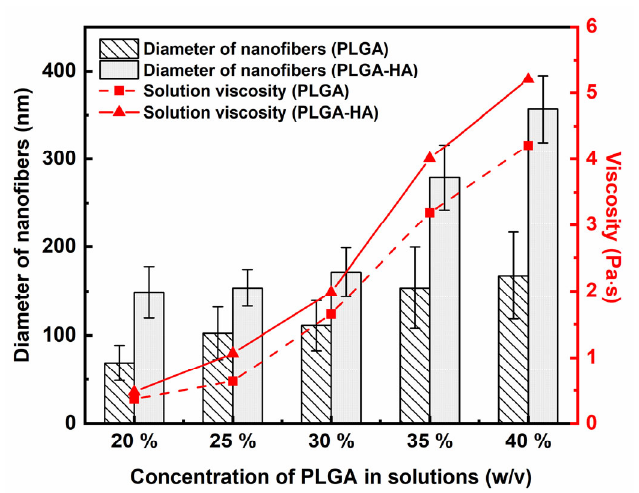
Figure 8. Solution viscosity of electrospinning solutions at different concentrations, and diameter evaluation of their corresponding electrospun nanofibers. n = 150.